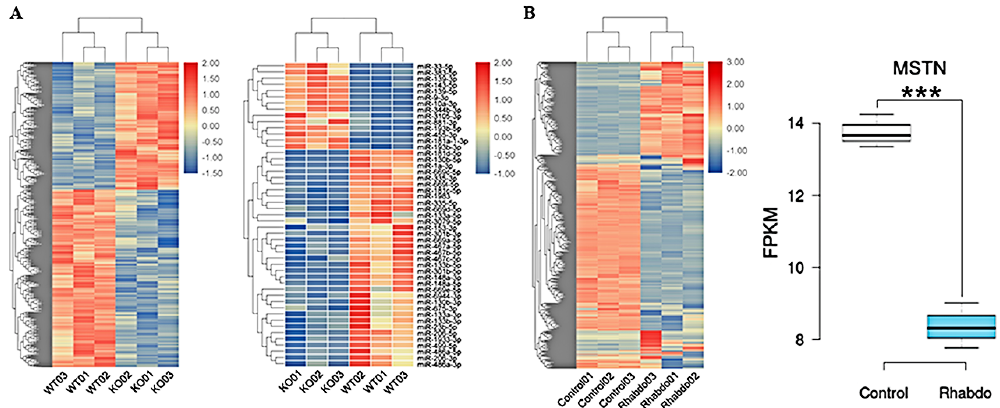
Figure 2. Differentially expressed genes (DEGs) and differentially expressed miRNAs (DEMs) in KO cell lines. ( A ) Heatmap hierarchical clustering revealed the presence of DEGs and DEMs in the MSTN-KO groups compared with the control groups. ( B ) Expression of DEGs displayed by heatmap hierarchical clustering and the expression levels of MSTN in the control groups and the rhabdo groups. *** p < 0.001.